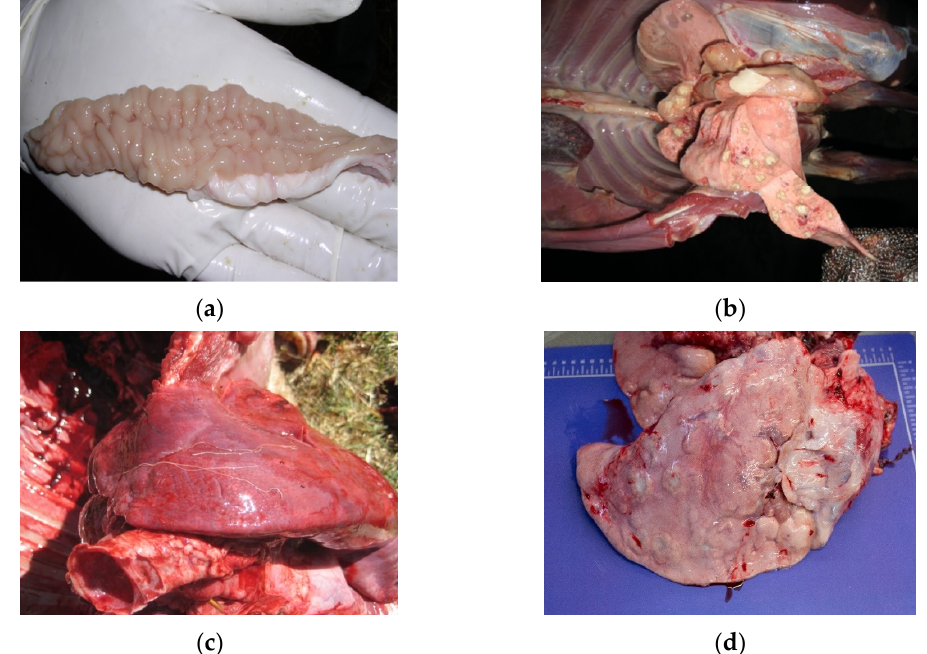
Figure 4. ( a ) Paratuberculosis; ( b ) Tuberculosis; ( c ) Lungworms; ( d ) Adenomatosis.